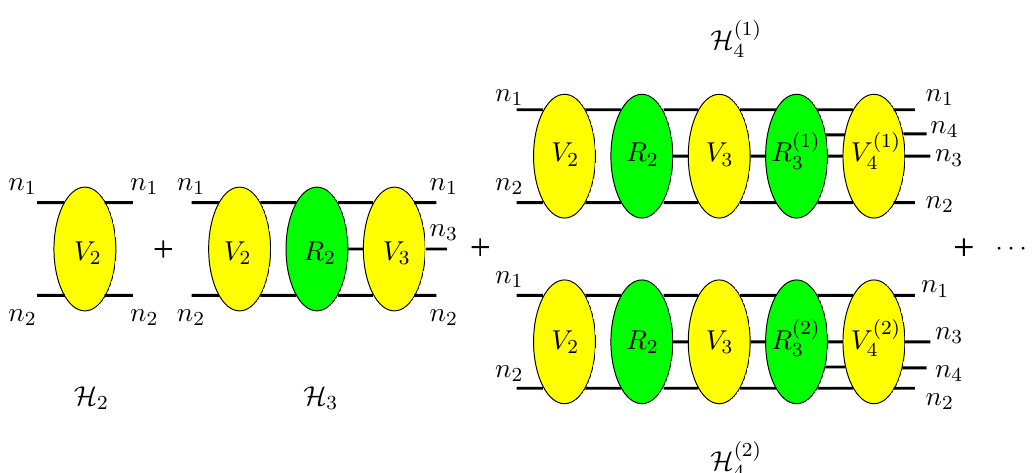
Figure 11 . Diagrammatic representation of the lowest hard functions contributing to